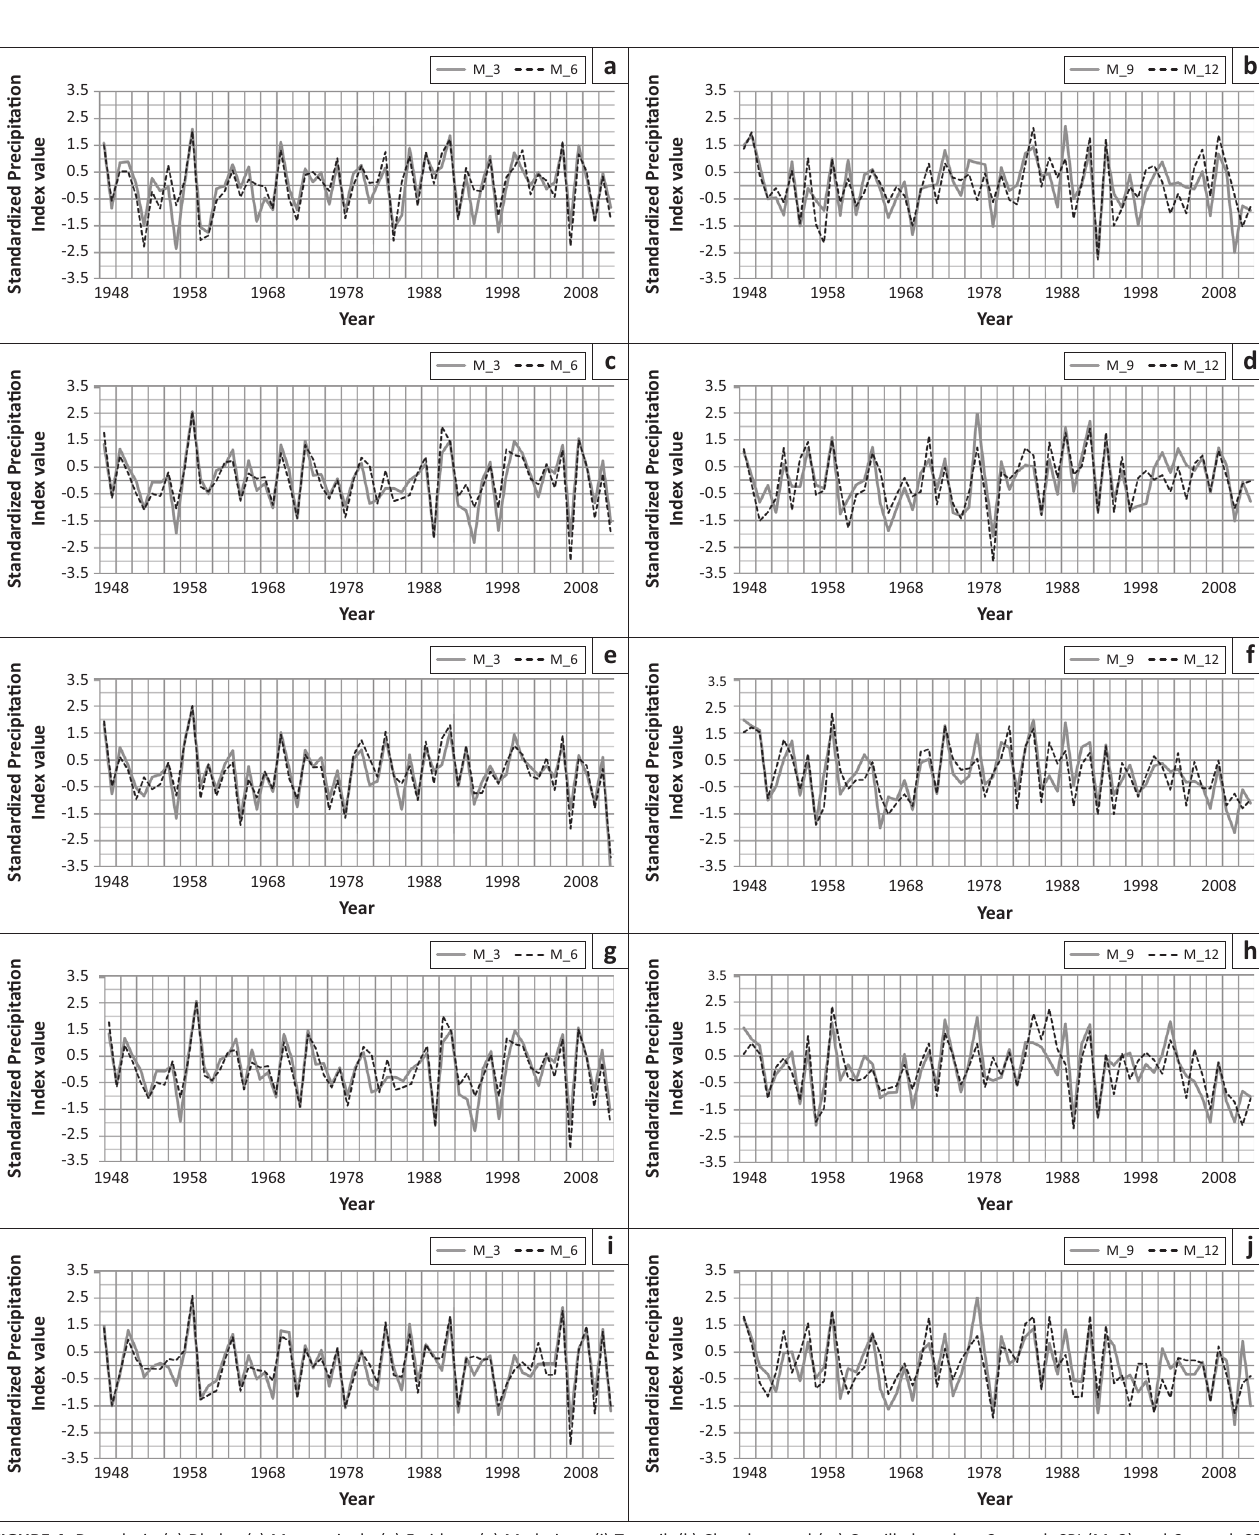
FIGURE 4: Drought in (a) Dhaka, (c) Mymensingh, (e) Faridpur, (g) Madaripur, (i) Tangail, (k) Chandpur and (m) Comilla based on 3-month SPI (M_3) and 6-month SPI (M_6). Drought in (b) Dhaka, (d) Mymensingh, (f) Faridpur, (h) Madaripur, (j) Tangail, (l) Chandpur and (n) Comilla based on 9-month SPI (M_9) and 12-month (annual) SPI (M_12). normal droughts had occurred based on 12-month SPI (Figure 5). The adjacent part of the Chittagong region, Sitakunda experienced 2 extreme droughts, 4 severe droughts, 3 moderate droughts and 22 normal droughts based on 3-month SPI; 2 extreme droughts, 3 severe droughts, 3 moderate droughts and 26 normal droughts